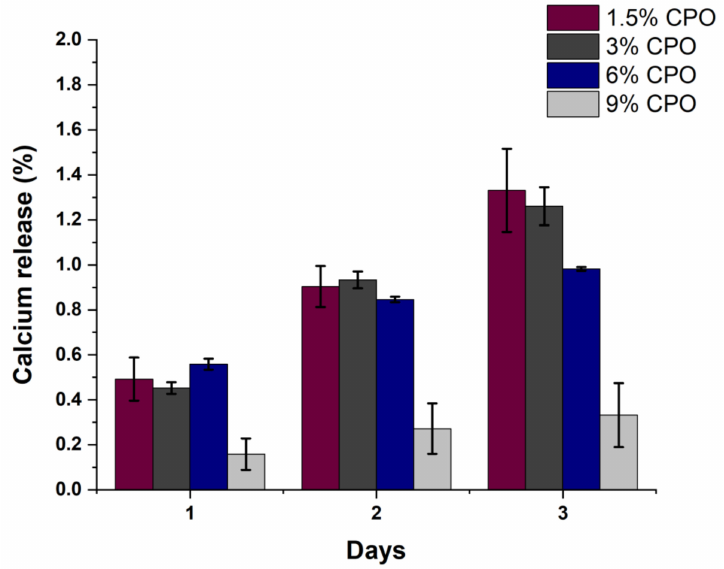
Figure 4. Calcium release percentage of samples over a three-day period ( n = 3).